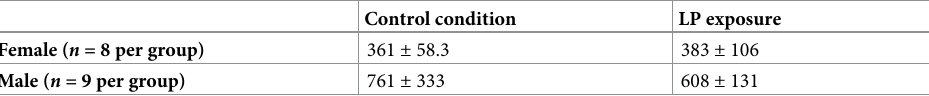
Table 1. Total activity scores for female and male mice. Behaviors of each mouse during the 30 min before and 30 min after the beginning of LP stimulation were recorded (LP exposure). In control animals, the total activity score was calculated over a period of 60 min without LP stimulation (Control condition). Each number represents the mean ± standard error of the activity